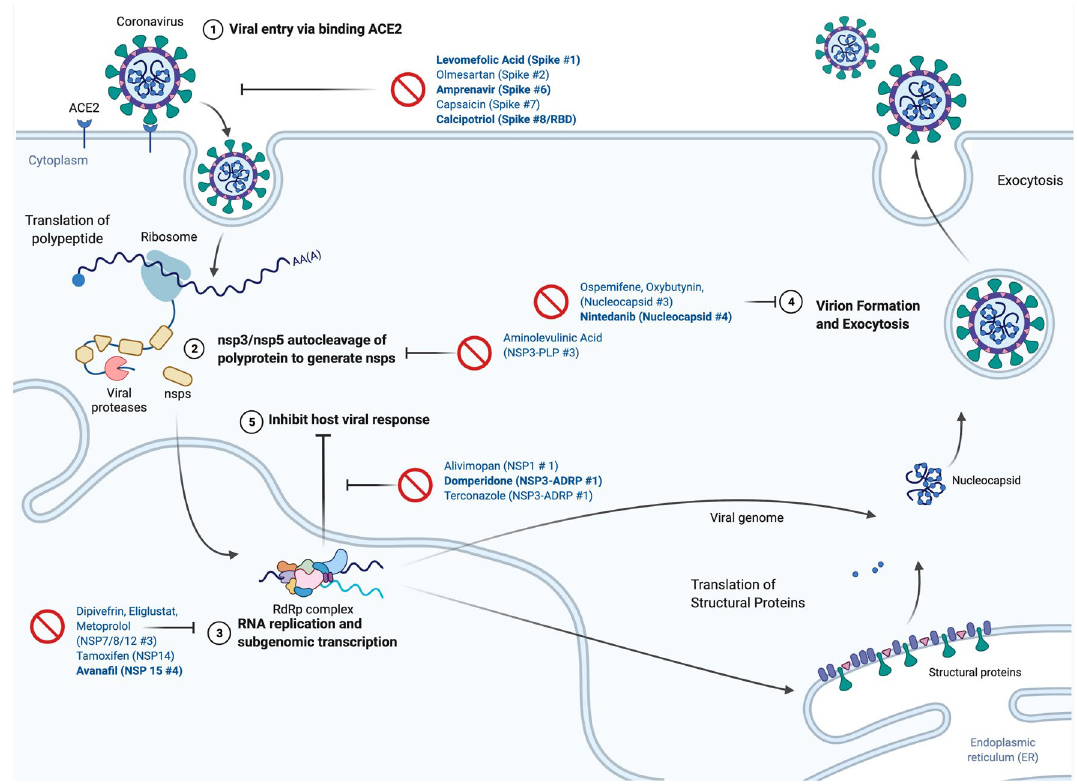
Figure 5. Predicted Sites and Mechanism of 17 “High-Confidence” drug/site pairs. The 17 drugs with Z score ≥ 2 at 5 or fewer target sites and previously identified anti-SARS-CoV-2 activity in vitro . The predicted drug/site pairs and commonly drugged steps in the (simplified) viral life cycle . including (1) blockade of viral entry mediated via the S protein recognizing the host ACE2; (2) inhibition of viral proteases NSP3 and NSP5 which auto-cleave and activate the 16 nsps, (3) inhibition of the viral replication/transcription complex; (4) blockade of virion formation, RNA packaging, and exocytosis, and (5) blockade of viral proteins that attenuate the host immune response. Drugs names in bold indicate are “High-Confidence” hits predicted to form stable drug/receptor interaction in molecular dynamics simulations, non-bolded drugs failed to form stable complexes in the MD simulations. Drug lists ordered as, “Drug (Protein Site #)”. Created with